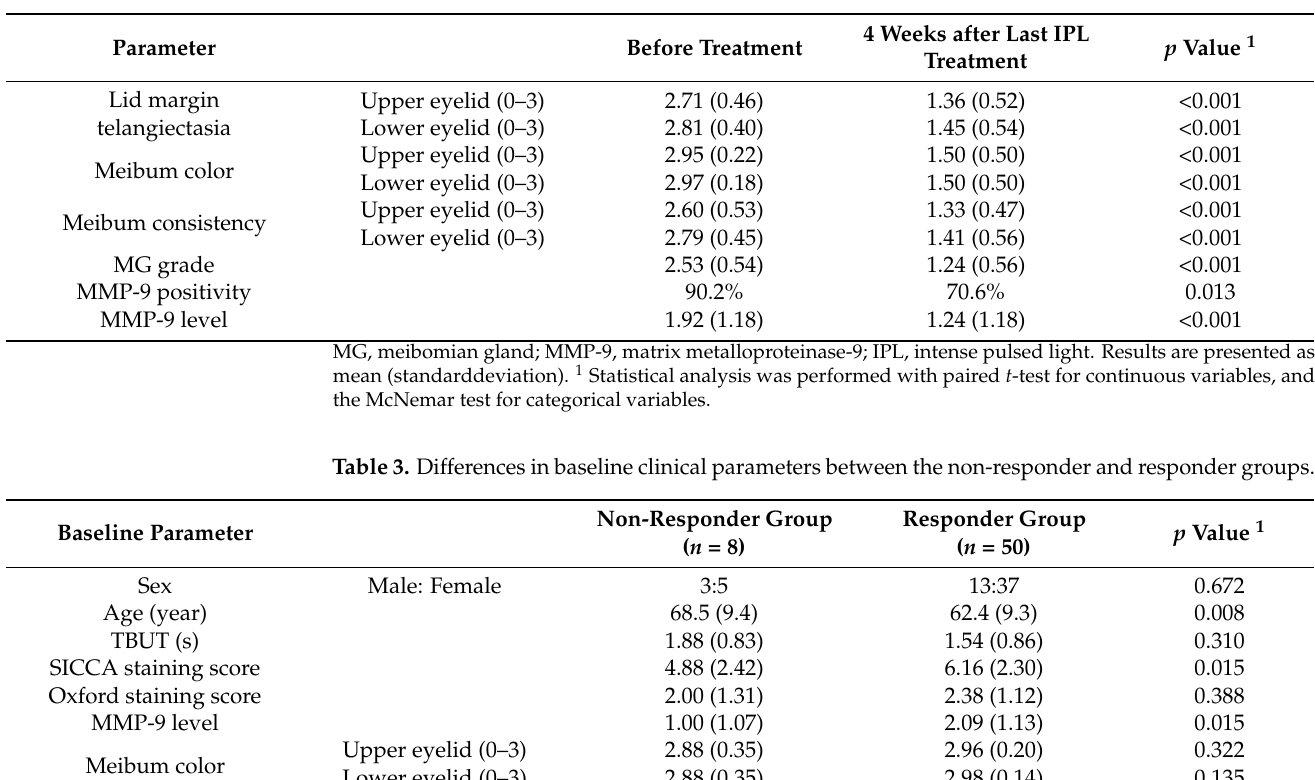
Table 2. Lid margin telangiectasia, meibomian gland function, and MMP-9 positivity before and four weeks after the last IPL treatment using a vascular filter in patients with moderate and severe meibomian gland dysfunction.